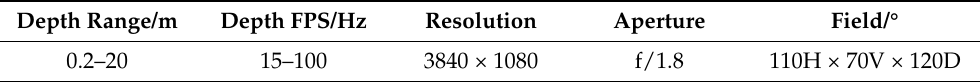
Table 2. Depth camera basic